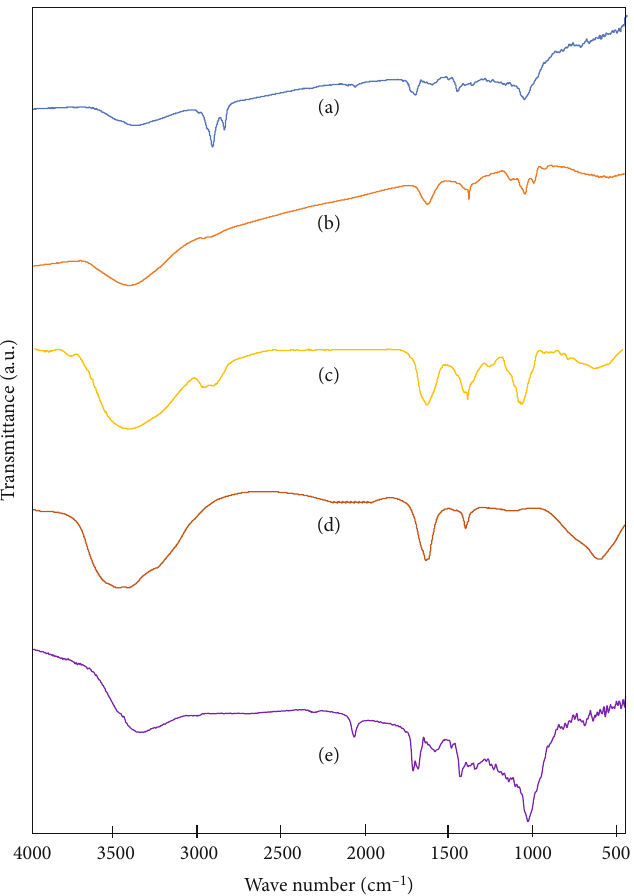
Figure 3: The FT-IR spectra of (a) betanin, (b) crocin, (c) acacetin, (d) indigo, and (e)